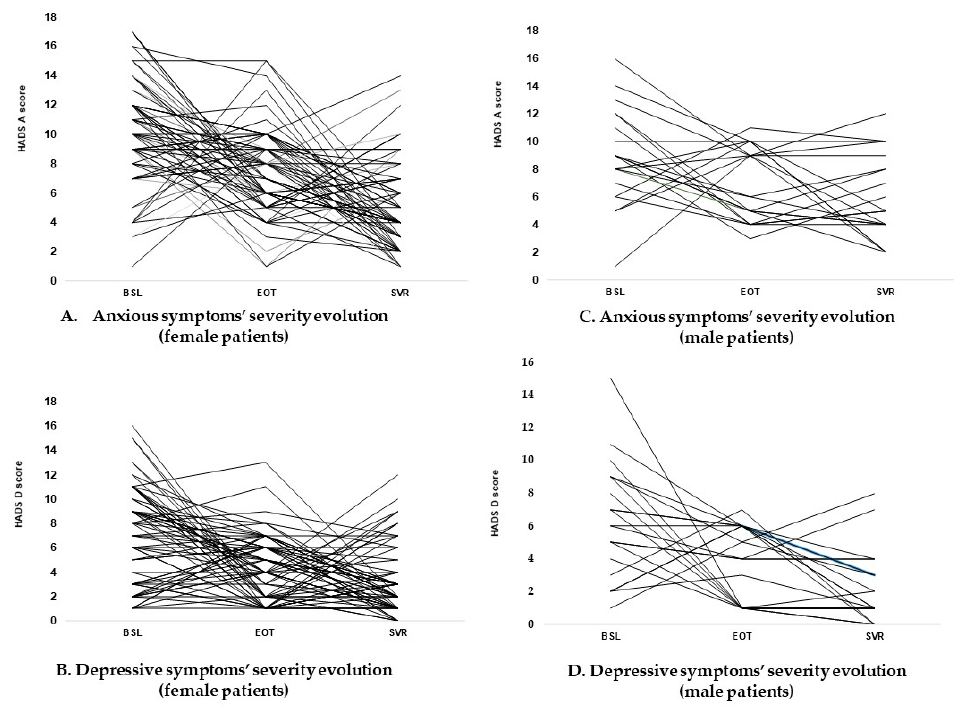
Figure 2. Graphic description of the anxious and depressive symptoms evolution during the study period (gender distribution). HADS scores showed similar patterns of the identified mental health disorders according to the patient’s gender. The dynamic measures of HADS scores showed a significant positive evolution of the psychological status for the subjects included in the study. ( A ) Evolution of HADS-A scores at the three moments of assessment in female subjects; ( B ) Evolution of HADS-D scores at the three moments of assessment in female subjects; ( C ) Evolution of HADS-A scores at the three moments of assessment in male subjects; ( D ) Evolution of HADS-D scores at the three moments of assessment in male subjects.